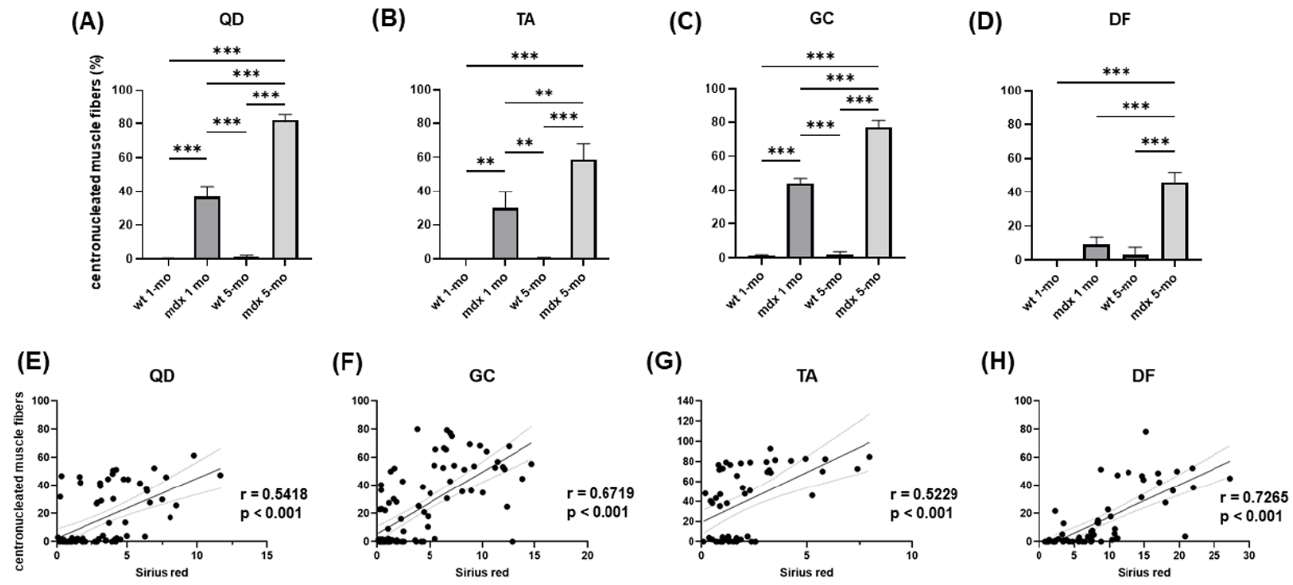
Figure 5. ( A – D ) Bar graphs showing the percentage of centronucleated muscle fibres in the considered muscles from young and adult wt and mdx mice. Data are mean ± SD. ( E – H ) Correlations showing the relationship between the percentage of centronucleated skeletal muscle fibres and the collagen content in the same muscles. ** p < 0.01; *** p < 0.005.